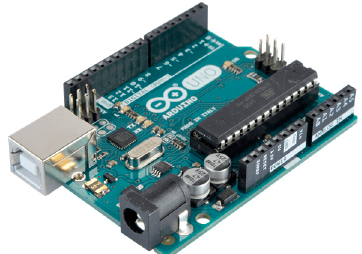
Sensors 2019 , 19 , 495